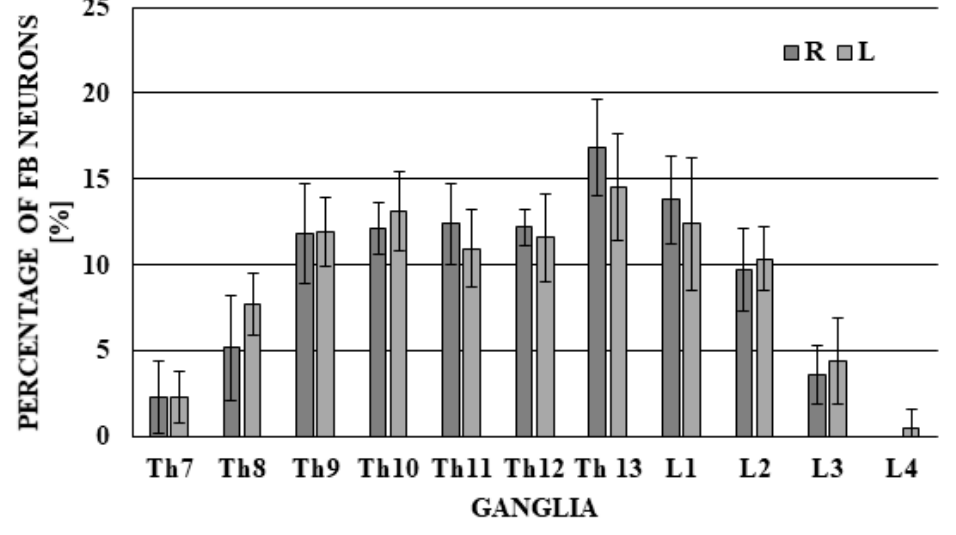
Figure 1. The distribution of fast blue (FB)-labelled neurons supplying the porcine ileocecal valve located in dorsal root ganglia (DRG). The total number of FB-positive neurons located in left and right DRG was considered as 100% (separately for left and right DRG).